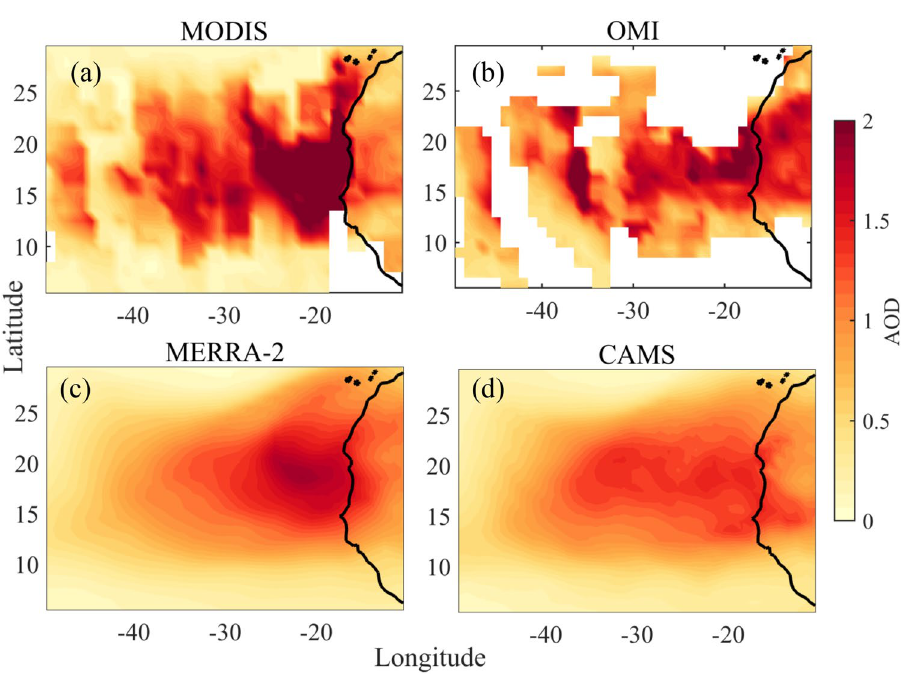
Figure 5. Time average spatial map of Aerosol optical depth (AOD) during the dust storm using datasets from ( a ) MODIS ( b ) OMI ( c ) MERRA-2 and ( d ) CAMS. The map was generated using MATLAB 2015b, www. mathw orks.